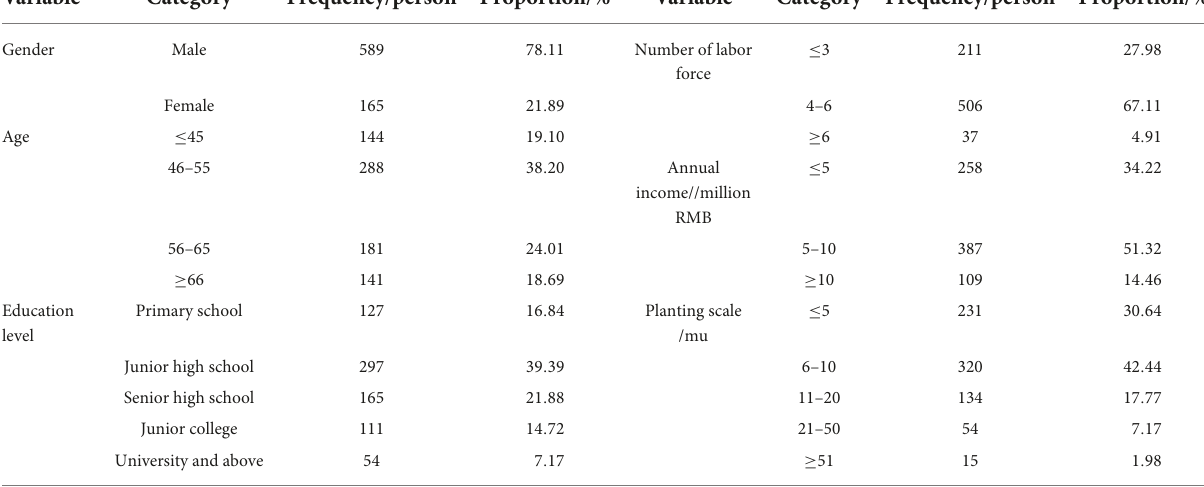
TABLE 2 Basic information of sample